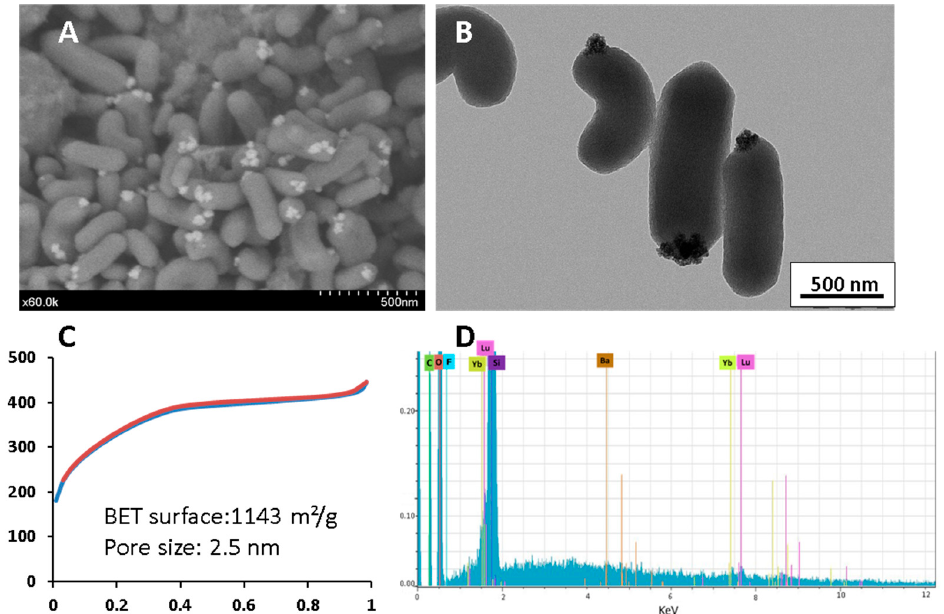
Figure 1. ( A ) SEM image of BaLuF 5 : Yb 3+ -Er 3+ @Ethylene ( B ) TEM of BaLuF 5 : Yb 3+ -Er 3+ @Ethylene, scale bar 500 nm. ( C ) N 2 adsorption–desorption experiment of Yb 3+ -Er 3+ , BaLuF 5 @Ethylene ( D ) EDX analysis of BaLuF 5 : Yb 3+ -Er 3+ @Ethylene. C, O, F, Yb, Lu, Si, Ba, Yb, Lu elements were